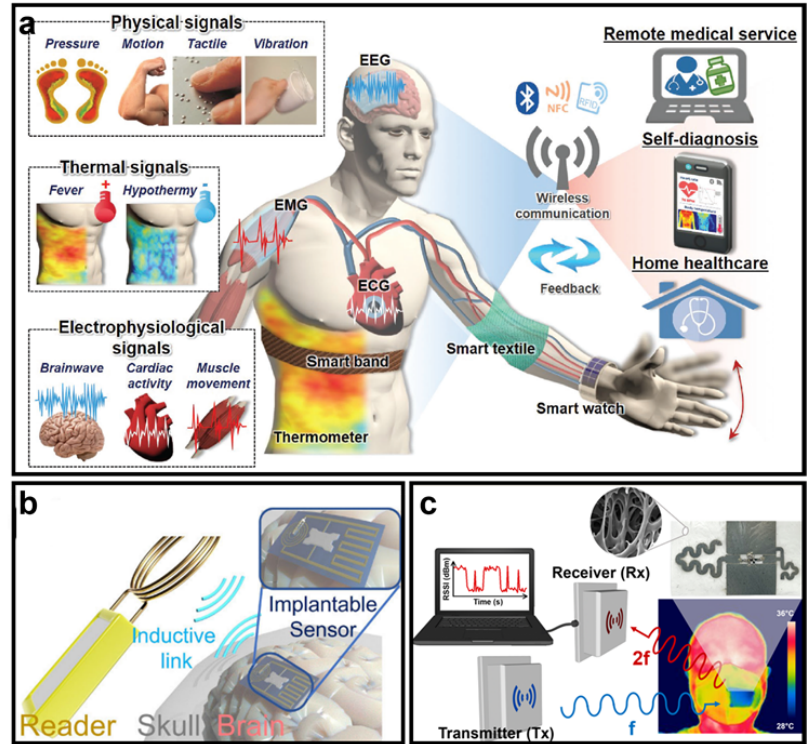
Figure 7. ( a ) A comprehensive diagram of wearable healthcare monitoring systems (reprinted with permission from Ref. [119], Copyright 2018 Royal Society of Chemistry). ( b ) Diagram of a wireless intracranial pressure monitoring system based on a nanomaterial-enabled piezoresistive sensor (reprinted with permission from Ref. [120], Copyright 2022 Institute of Electrical and Electronics Engineers). ( c ) Diagram of a smart face mask that can wirelessly monitor the mask-wearing condition and the cough frequency (reprinted with permission from Ref. [121], Copyright 2022 American Chemical